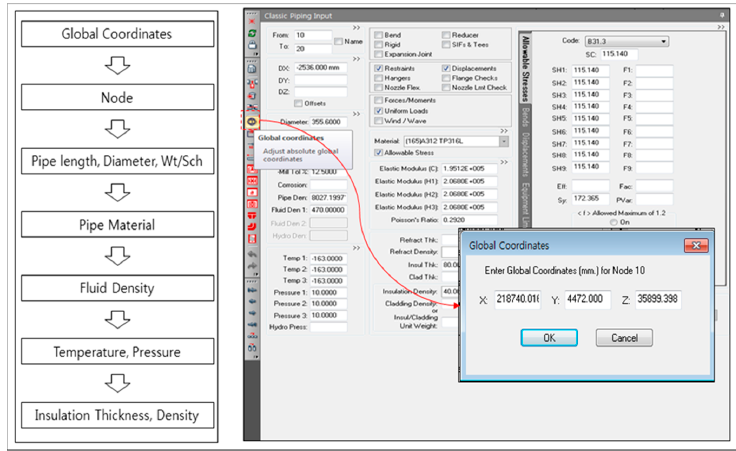
Figure 6. Schematic procedures for modeling pipes.